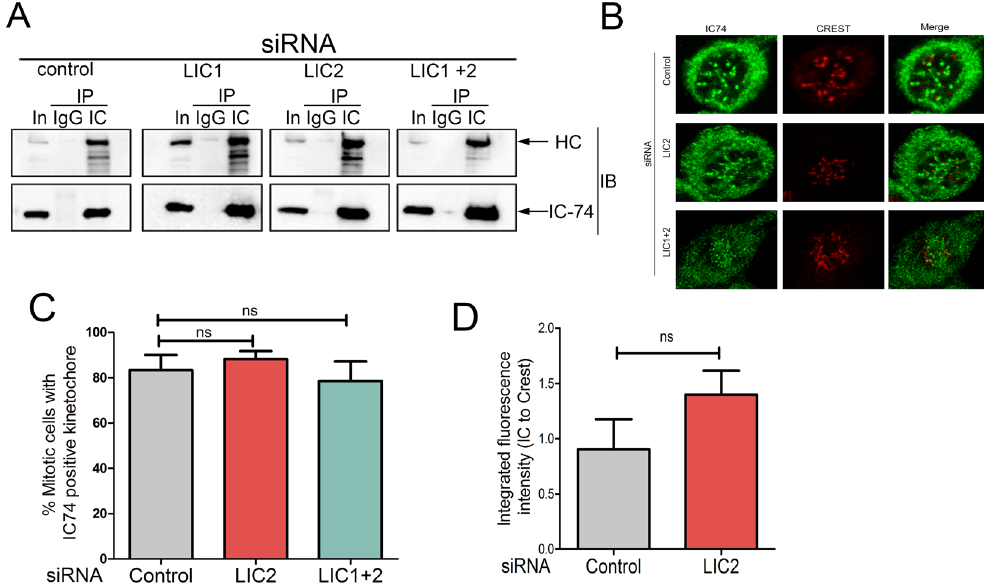
Figure 2. Dynein retains its integrity and mitotic localization upon LIC2 depletion. ( A ) Immunoprecipitation with IC74 co-precipitates HC irrespective of LIC depletion. In = Input, IP = immunoprecipitation, IB = immunoblot. ( B ) Representative confocal immunofluorescence images showing localization of IC74 to kinetochores (CREST). ( C ) Percent HeLa cells showing the proper localization of IC74 to kinetochores (CREST) upon respective siRNA treatment. (3 experiments, n = at least 17 prometaphase cells per experiment). ( D ) Integrated fluorescence intensity of IC74 staining as a ratio to CREST staining at kinetochores from the cells in C (10 cells per experiment from 3